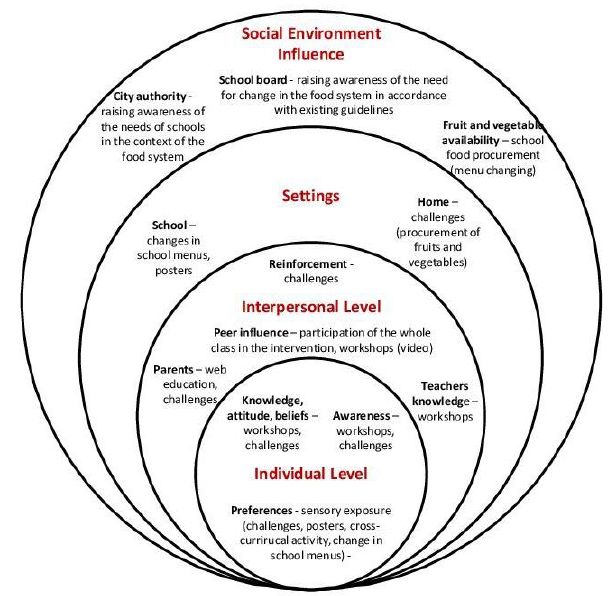
Figure 1. The socio-ecological framework for the intervention.